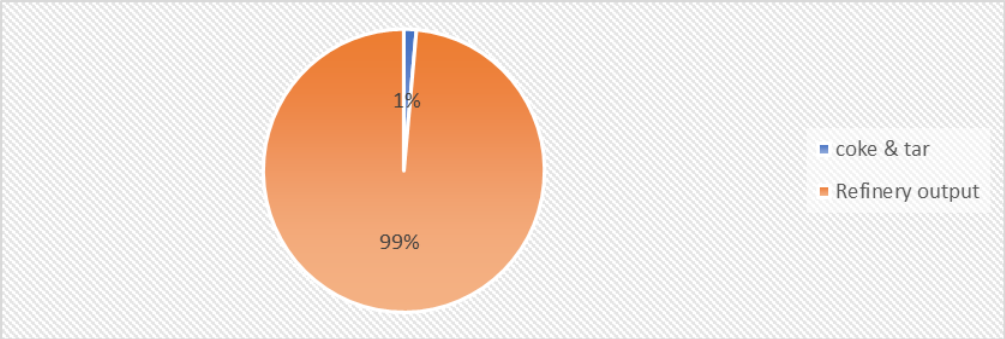
Figure 10. Exergy outputs of by-products of the CO sector (2017).